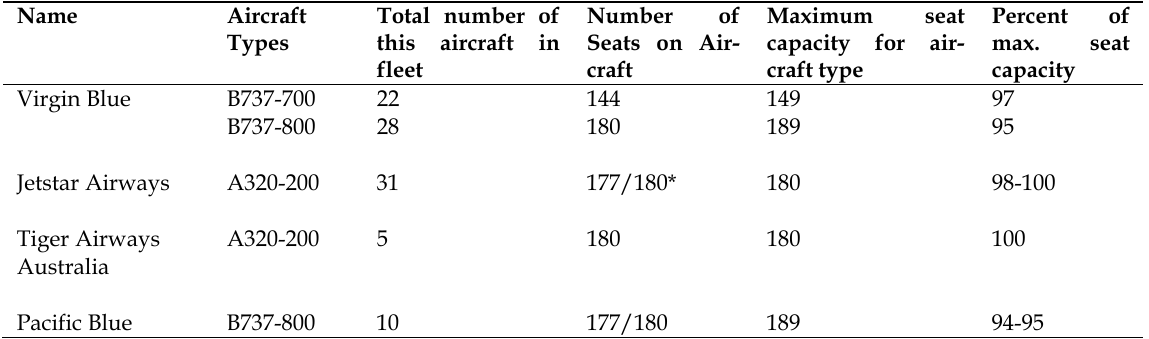
Table 7. Seating Density (February